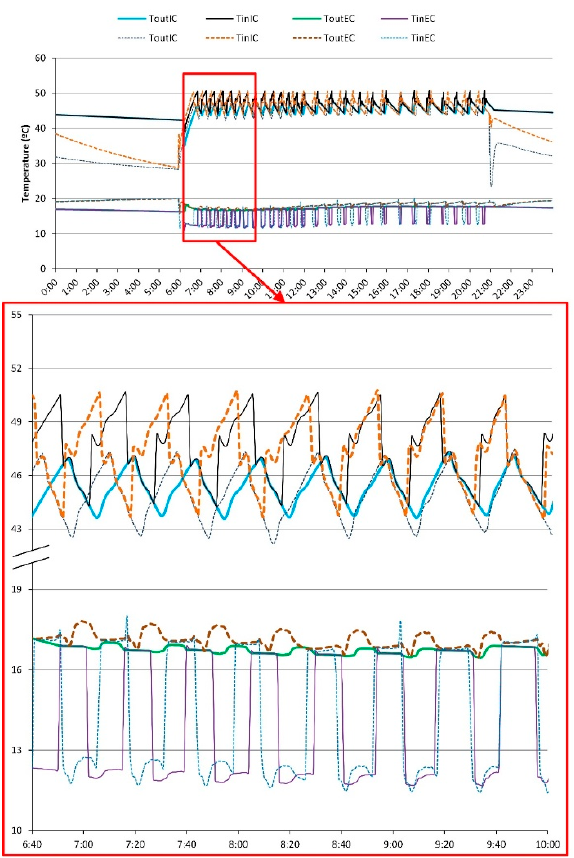
Figure 10. Short-term simulated temperature evolution: experimental (dashed line) vs. simulated